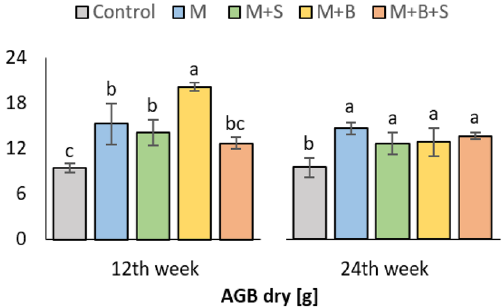
Figure 1. Dry aboveground biomass of barley under (12th week) and maize under (24th weeks) duration. Average values (n = 4) are displayed, error bars are standard error of mean. The different letters of variant values indicate a statistical difference among them at the level p ≤ 0.05.